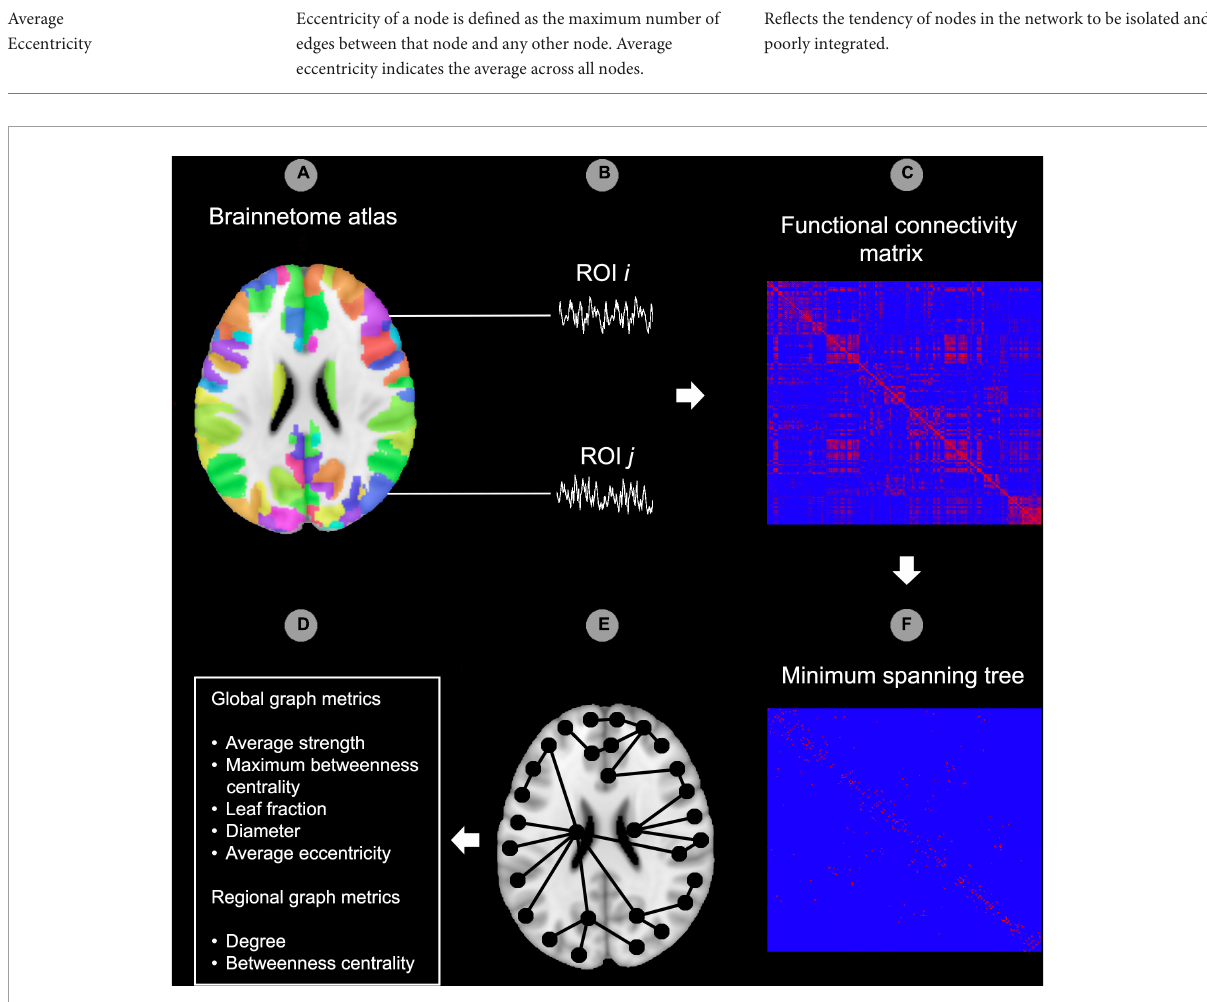
FIGURE1 Graph analysis pipeline. In the first step, the Brainnetome atlas was applied to the functional data (A) . The second step consisted of extracting the time-courses for each region of interest (ROI) of the atlas (B) . After this, functional connectedness was calculated between all possible pairs of ROIs i and j in each subject (C) . Hereafter, the minimum spanning tree (MST) was constructed from the functional connectivity matrix by including the strongest connections while avoiding loops. All edges in the MST were set to 1 while edges outside the MST were set to 0 (D) . Image (E) provides a theoretical example of an MST superimposed on a template brain. As a final step, the MST network was characterized using global and regional (node specific) graph metrics (F) . ROI, region of interest. The reader is referred to the web version of this paper for the color representation of this